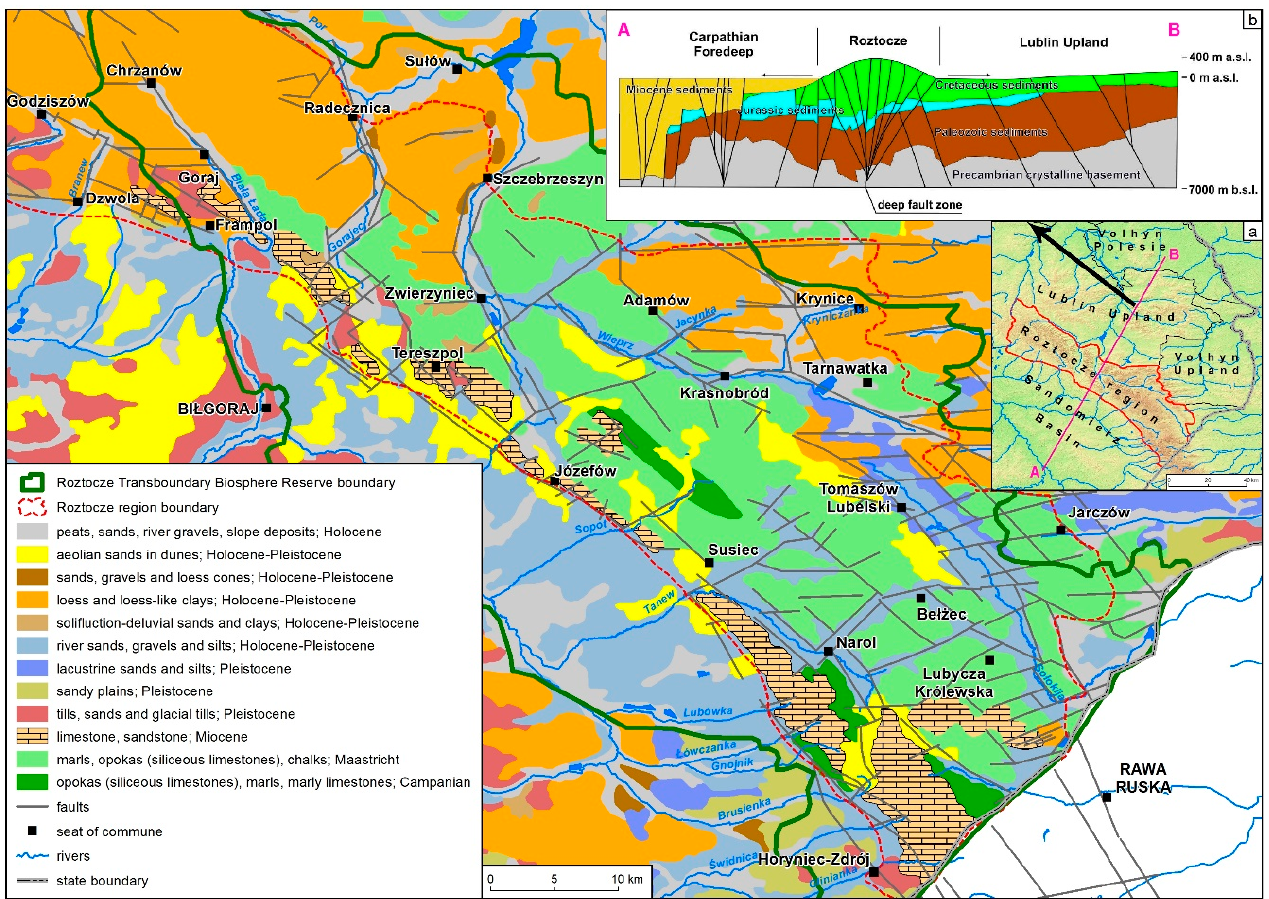
Figure 2. Geological characteristics of the Polish part of the Roztocze Transboundary Biosphere Reserve according to Malinowski, Mojski [31], Rzechowski, Kubica [32]; ( a ) Boundaries of the Roztocze region according to Solon et al. [8]; ( b ) schematic cross-section through the Roztocze region as a flower structure according to Jankowski, Margielewski [33], Cie ś li ń ski et al. [34].